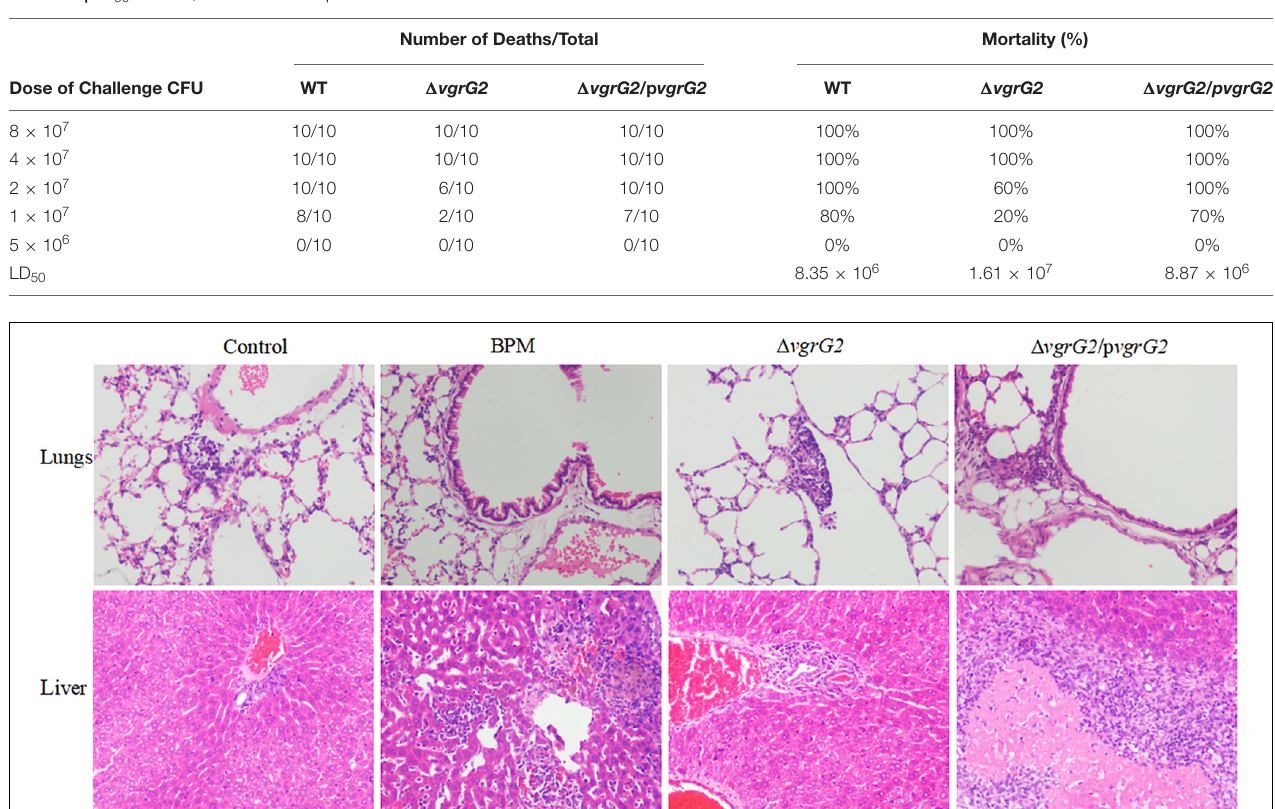
FIGURE 3 | Pathological characterization of lungs and liver tissues of BALB/c mice infected with BPM, mutant and complemented strains. Lungs and liver tissues of BALB/c mice infected with BPM, mutant, complemented strains and PBS (control) were prepared for light microscopy analysis and examined for differences in pathological changes (hematoxylin and eosin staining; original magnification × 200).